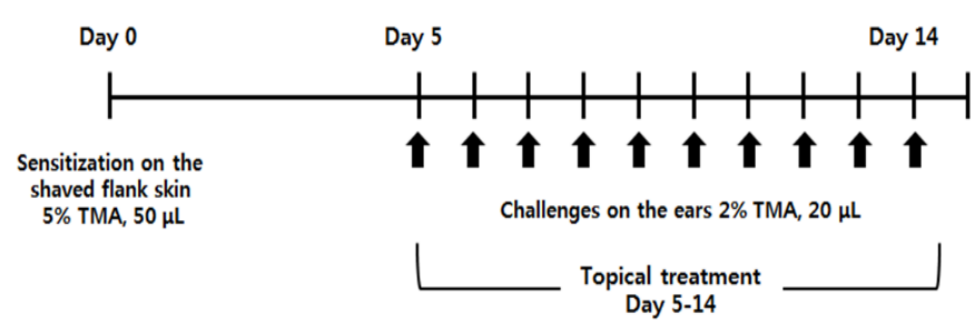
Figure 1. Experimental schedule of a TMA-induced AD-like mouse model. After sensitization of BALB/c mice by exposing them to 5% TMA (50 μL) on the shaved flank on Day 0, an AD-like symptom was induced on the ears of the mice by exposing them to 2% TMA (20 μL) on Days 5 to 14 daily. Piperine (2 and 4 mg/mL) or dexamethasone (10 μg/mL) was topically applied on Days 5 to 14 daily 1 h before TMA exposure.